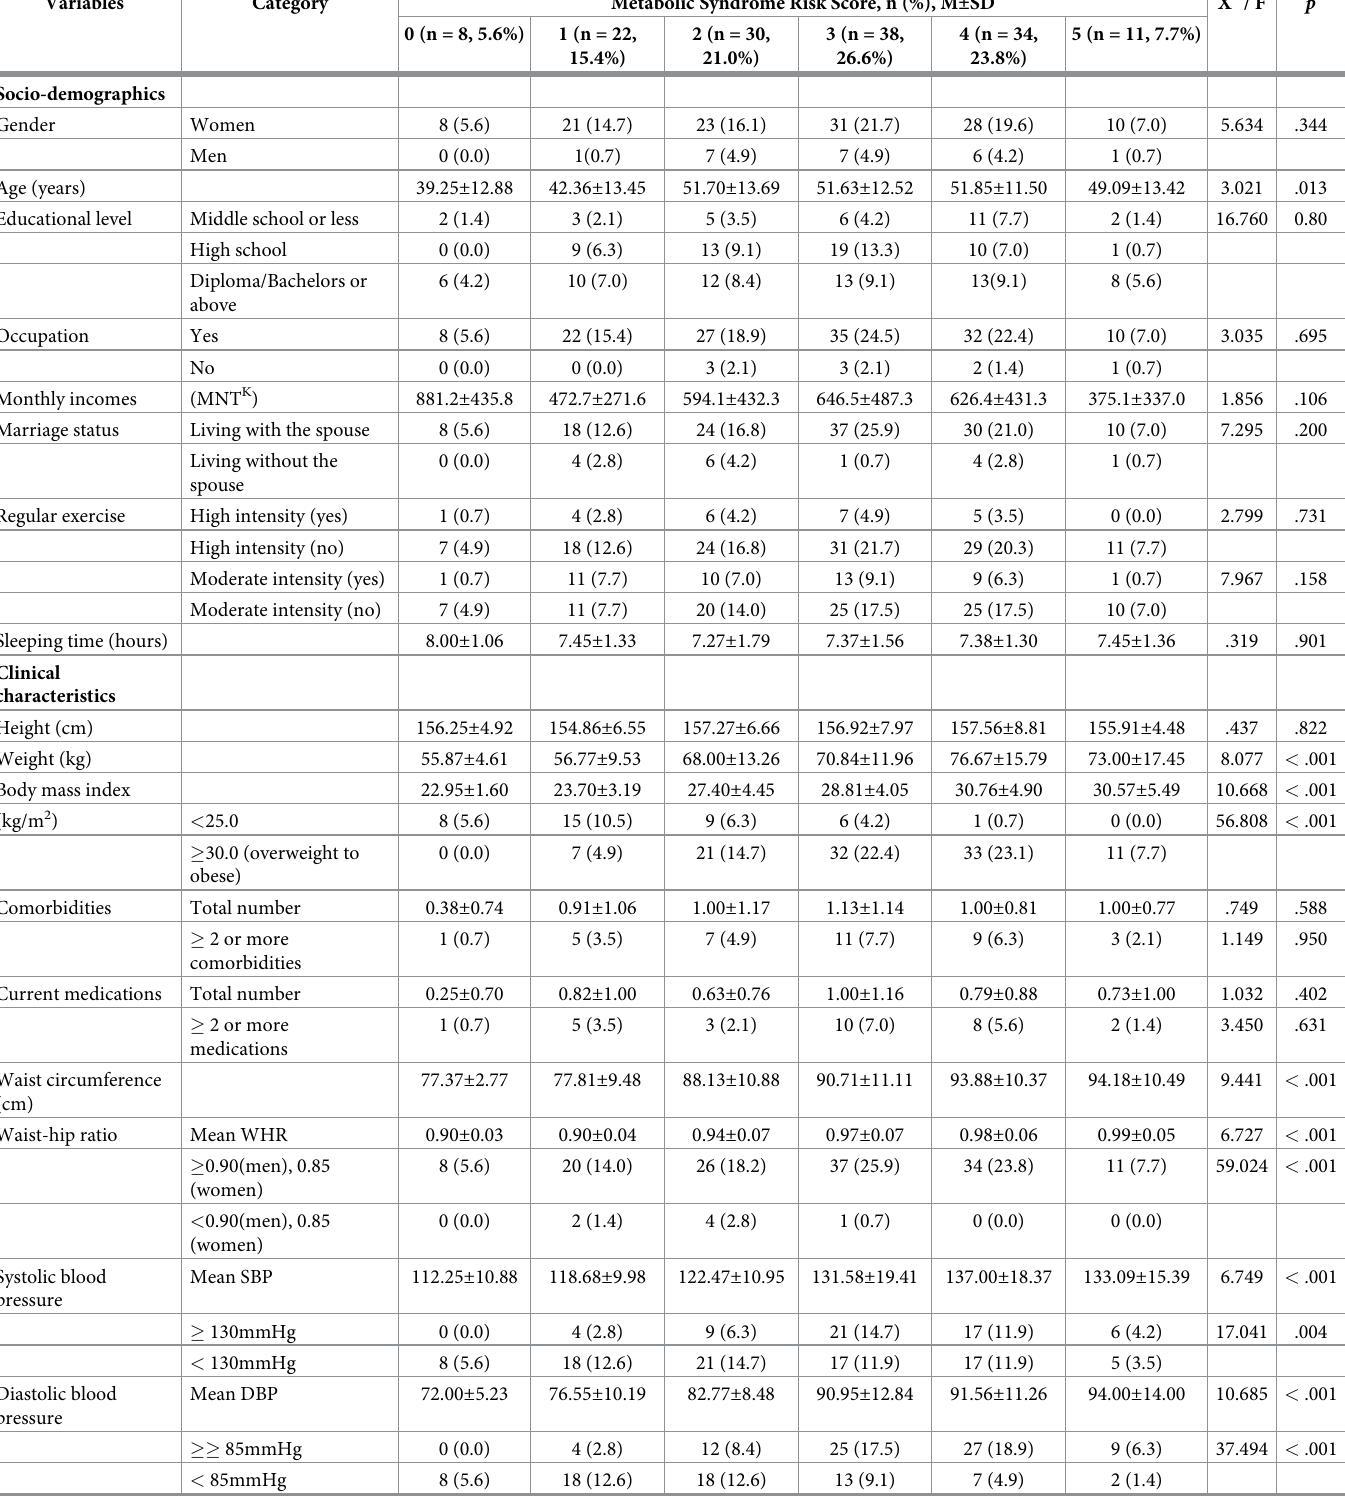
Table 2. Comparison of socio-demographic, clinical and psychological characteristics according to metabolic syndrome risk score ( N = 143).